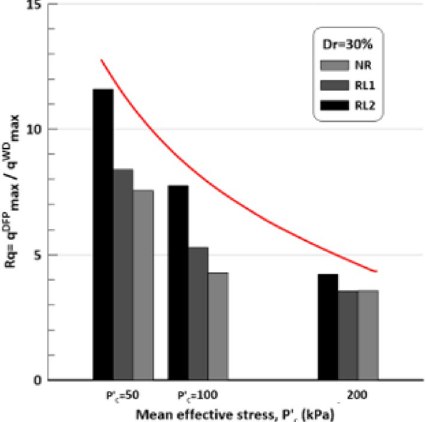
Fig. 14 Deviator stress ratio (Rq) of unreinforced and reinforced